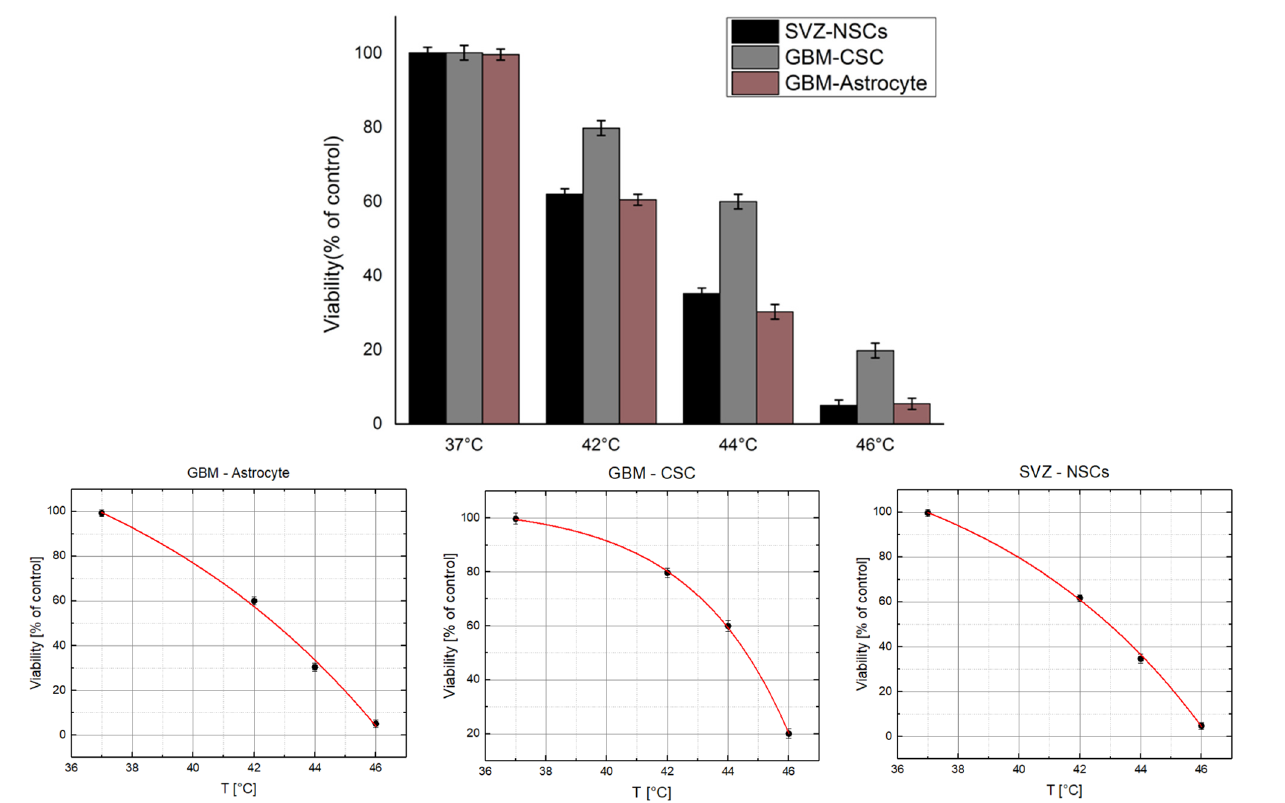
Figure 13. Glioblastoma cell survival rate for the SVZ, CSC, and astrocyte types applying different temperatures for 60 min (data from [96]) (top) and corresponding regression fits by means of (6) (bottom).